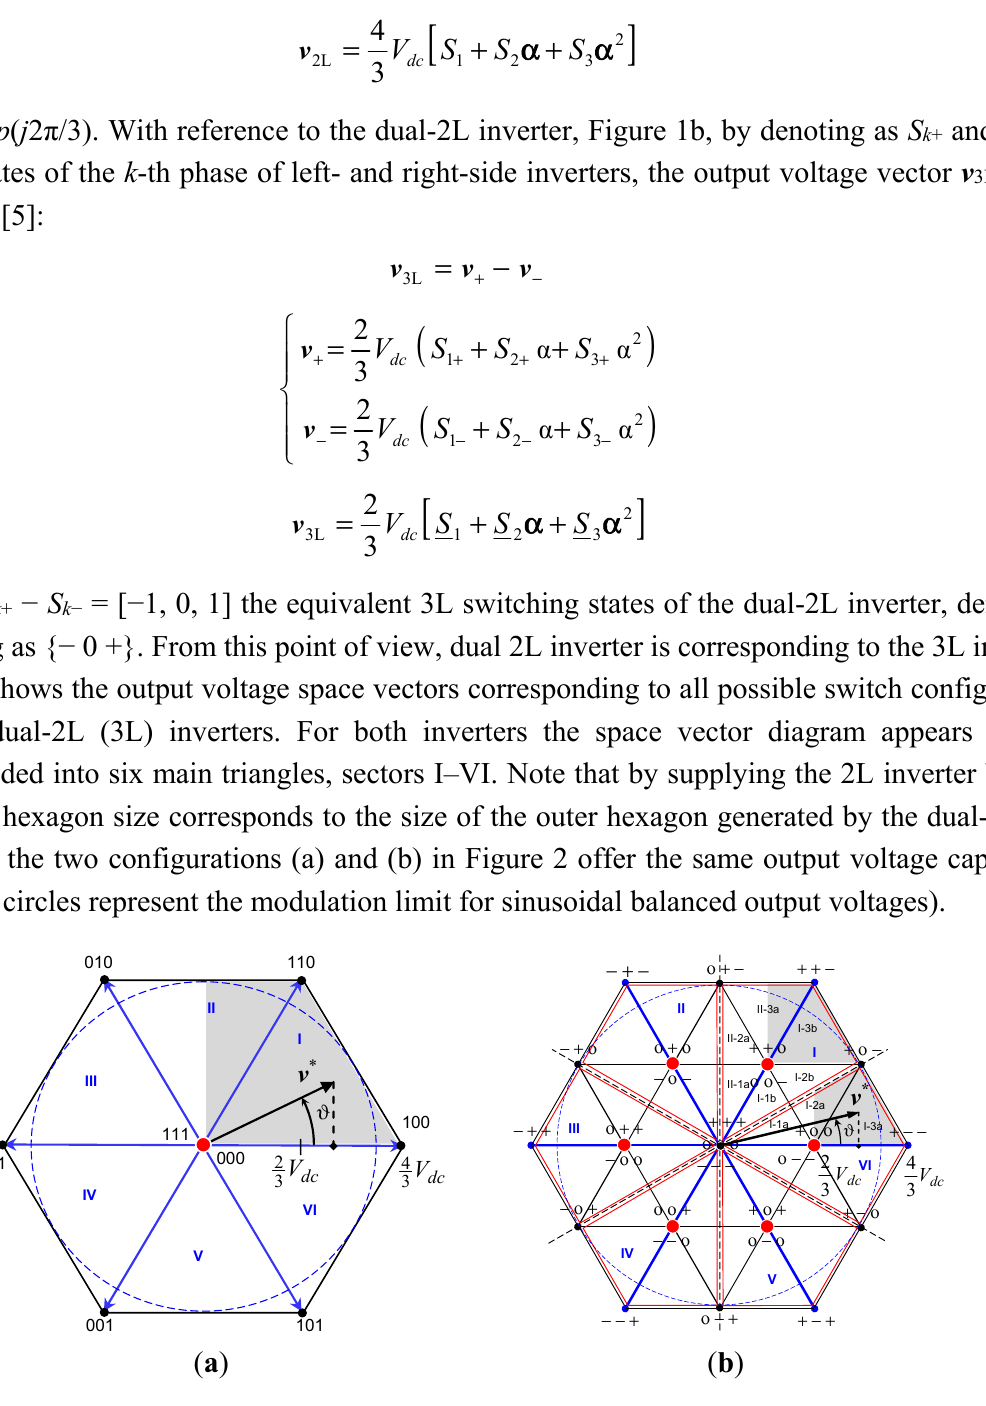
Figure 2. Output voltage space vector diagrams. ( a ) Single-2L inverter supplied by 2 V dc ; ( b ) dual-2L inverter (3L) supplied by V dc at each